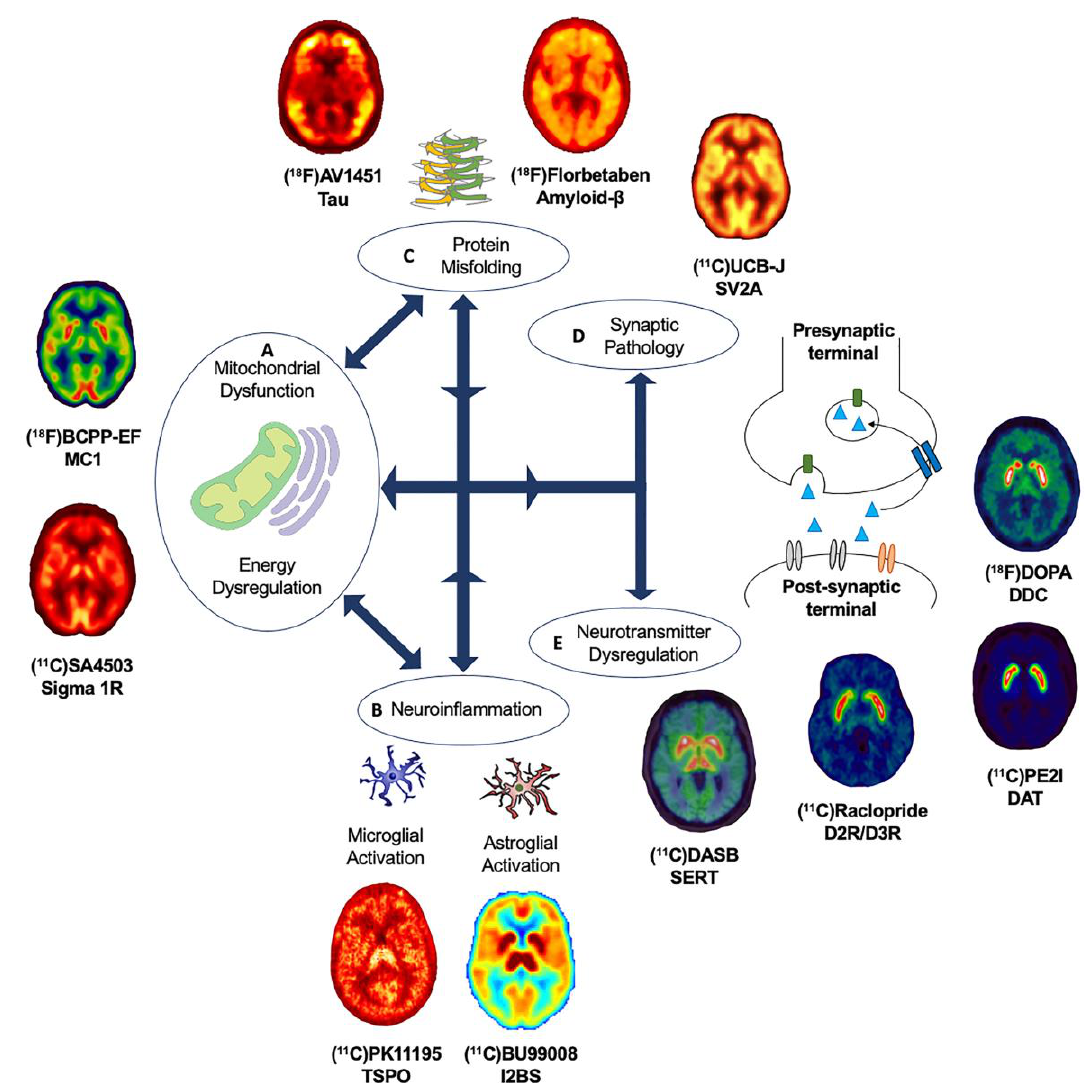
Figure 2. Overview of molecular pathways targeted with PET radioligands. ( A ) Mitochondrial dysfunction and energy dysregulation can be investigated using ( 18 F)BCPP-EF, for mitochondrial complex1and( 11 C)SA4503forsigma1receptor. ( B )Neuroinflammationcanbeinvestigatedbytargeting translator protein expressed on activated microglia using PET radioligands such as ( 11 C)PK11195 and astroglia activation using novel PET radioligands such as ( 11 C)BU99008 for imidazoline 2-binding sites. ( C ) Abnormal protein aggregation of tau and amyloid- β can be quantified using specific radioligands such as ( 18 F)AV1451 and ( 18 F)Florbetaben, respectively. ( D ) Synaptic pathology can be investigated using ( 11 C)UCB-J targeting synaptic vesicle glycoprotein 2A. ( E ) Dysregulation of neurotransmitter systems can be investigated by employing various PET radioligands, including serotonergic markers such as ( 11 C)DASB for the serotonin transporter and dopaminergic markers such as presynaptic markers ( 18 F)DOPA for dopamine storage, ( 11 C)PE2I for dopamine transporter and ( 11 C)Raclopride for postsynaptic dopaminergic receptors, as well as PET radioligands for noradrenergic, glutamatergic and GABAergic systems. Abbreviations: D2R / D3R: Dopamine type-2 / type-3 receptor, DAT: Dopamine transporter, DDC: Dopa Decarboxylase, I2BS: Imidazoline 2-binding sites, MC1: Mitochondrial Synaptic vesicle glycoprotein 2A and TSPO: Translocator protein.